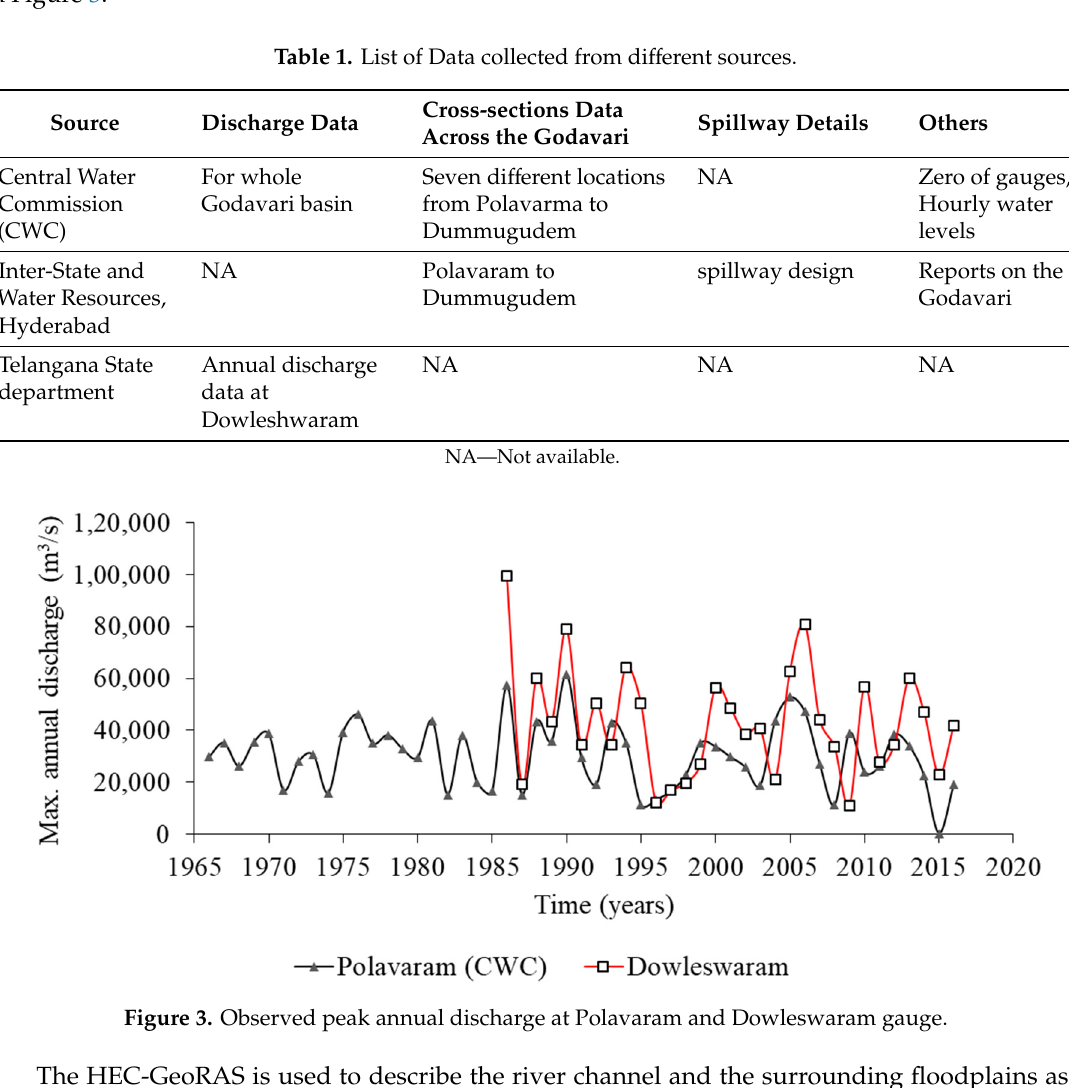
Table 1. List of Data collected from different sources.